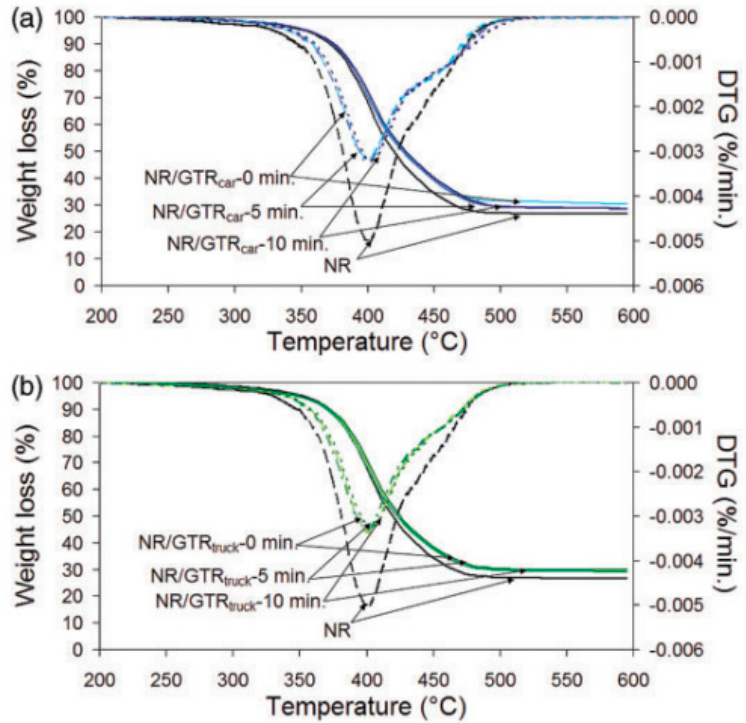
Figure 35. TGA and DTG curves of: ( a ) NR / GTR car and ( b ) NR / GTR truck samples (N 2 atmosphere and a heating rate of 20 ◦ C / min) (reproduced with permission from [131]). Table 6. Typical composition of passenger and truck tires (reproduced with permission from [131]). Composition Passenger Car Tire Truck